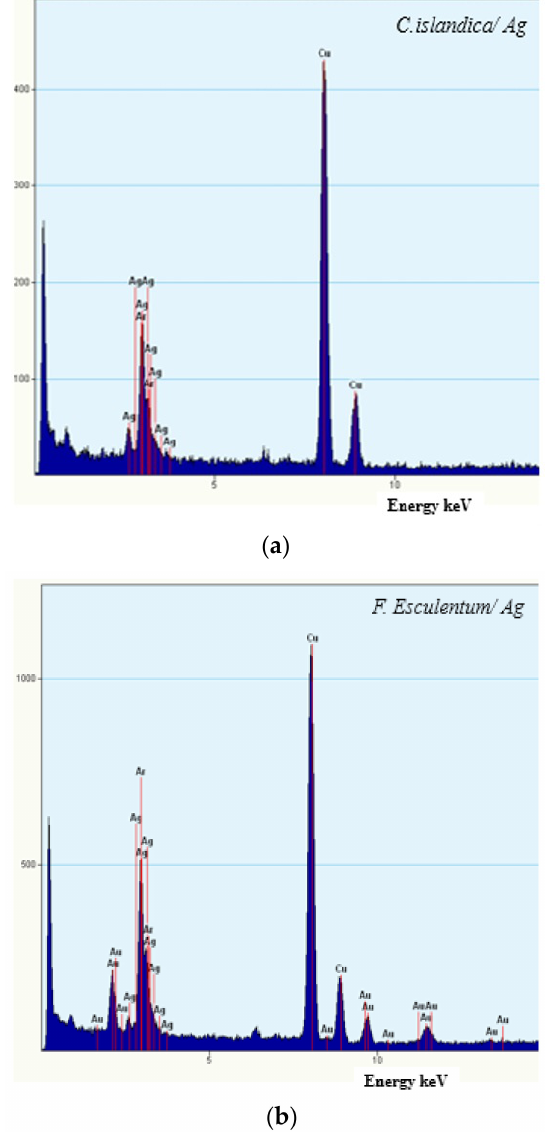
Figure 3. EDX spectra of green synthesized AgNPs using enzyme-assisted C. islandica ( a ) and F. esculentum ( b )